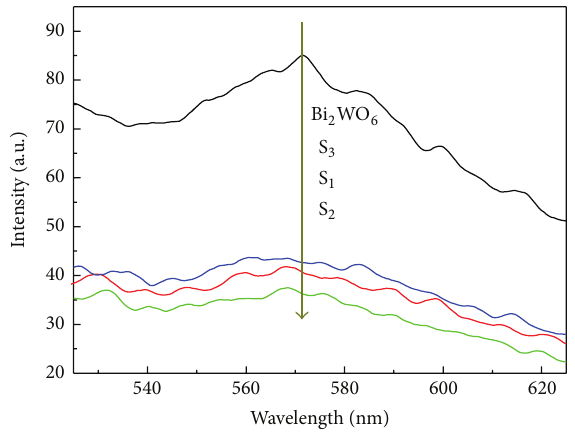
Figure 5: FL spectra of Bi 2 WO 6 , S 1 , S 2 , and S 3